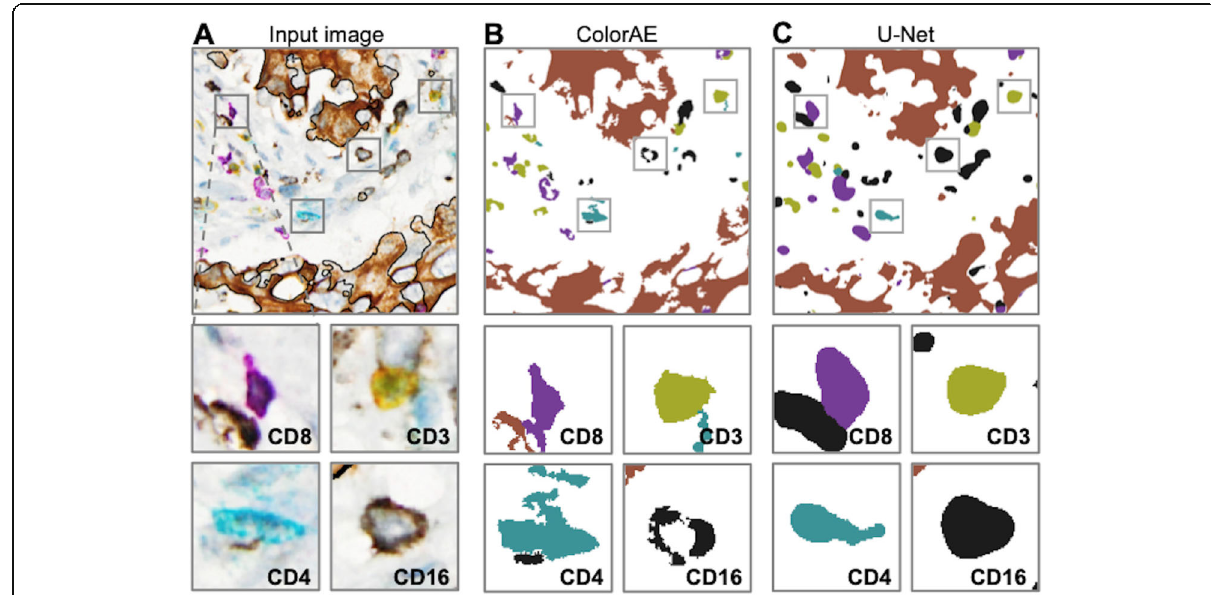
Fig. 4 ColorAE and U-Net predictions. a mIHC input image of tumor microenvironment, with a representative cell from each class of immune cells (magnified below). b - c ColorAE and U-Net prediction masks based on the original